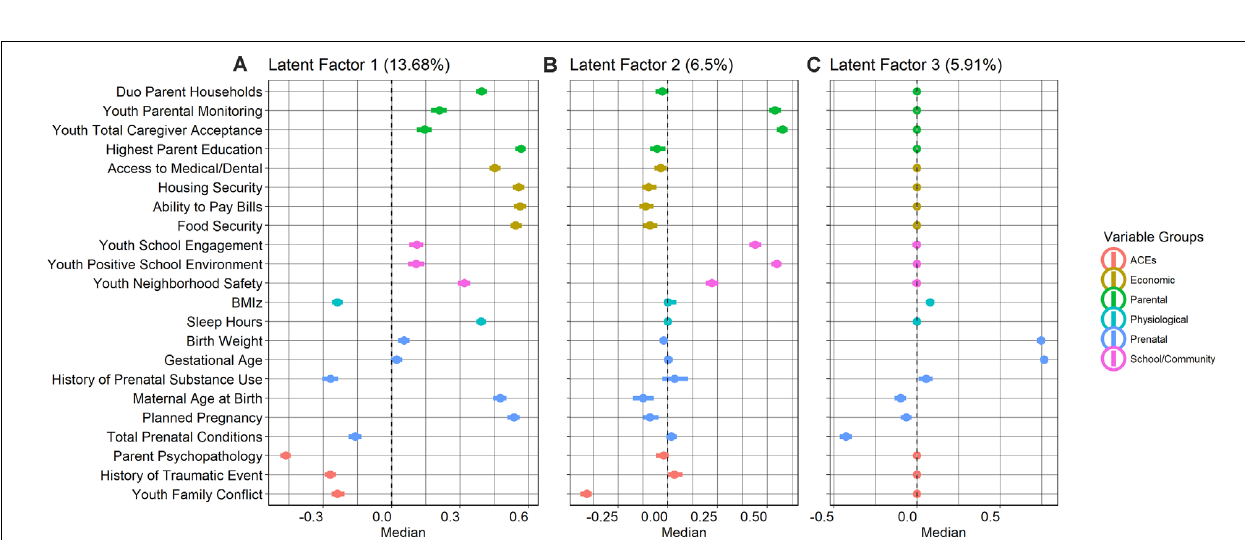
FIGURE 2 | Group factor analysis (GFA) median value loadings (with 95% confidence intervals) for each of the 22 measures for (A) latent factor 1: resources-to-adversity (13.68% variance explained); (B) latent factor 2: youth perceived social support (6.5% variance explained); and (C) latent factor 3: perinatal well-being (5.91% variance